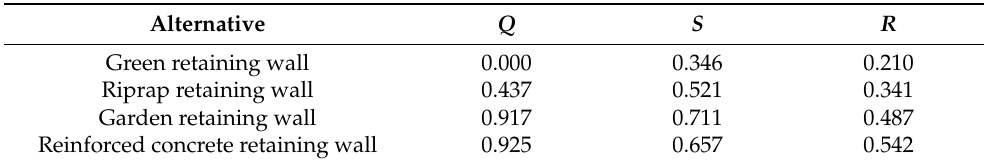
Table 5. Ranking of alternatives according to the VIKOR method. Project 1. Source: the authors’ own research.